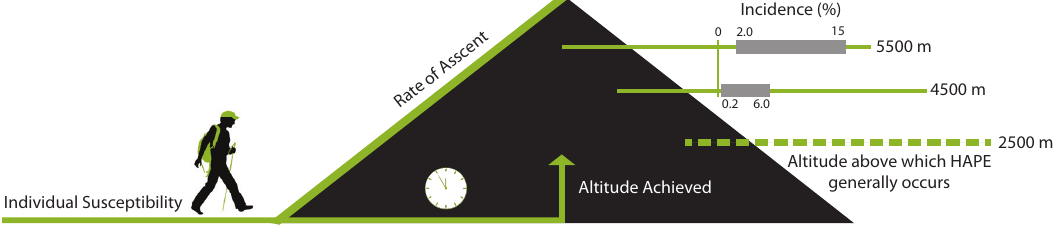
Figure. Incidence and risk factors for high altitude pulmonary edema